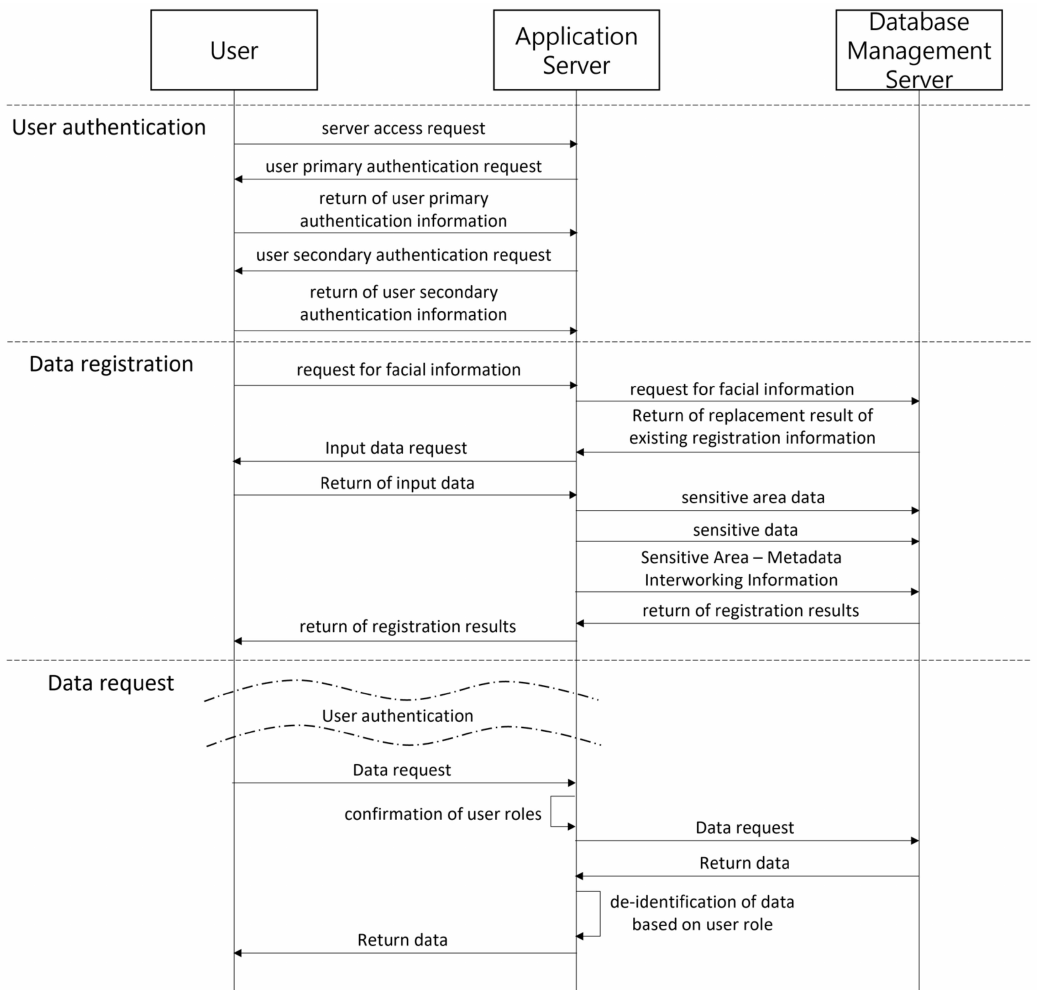
Figure 3. A diagram of the de-identification mechanism of user data in the imaging